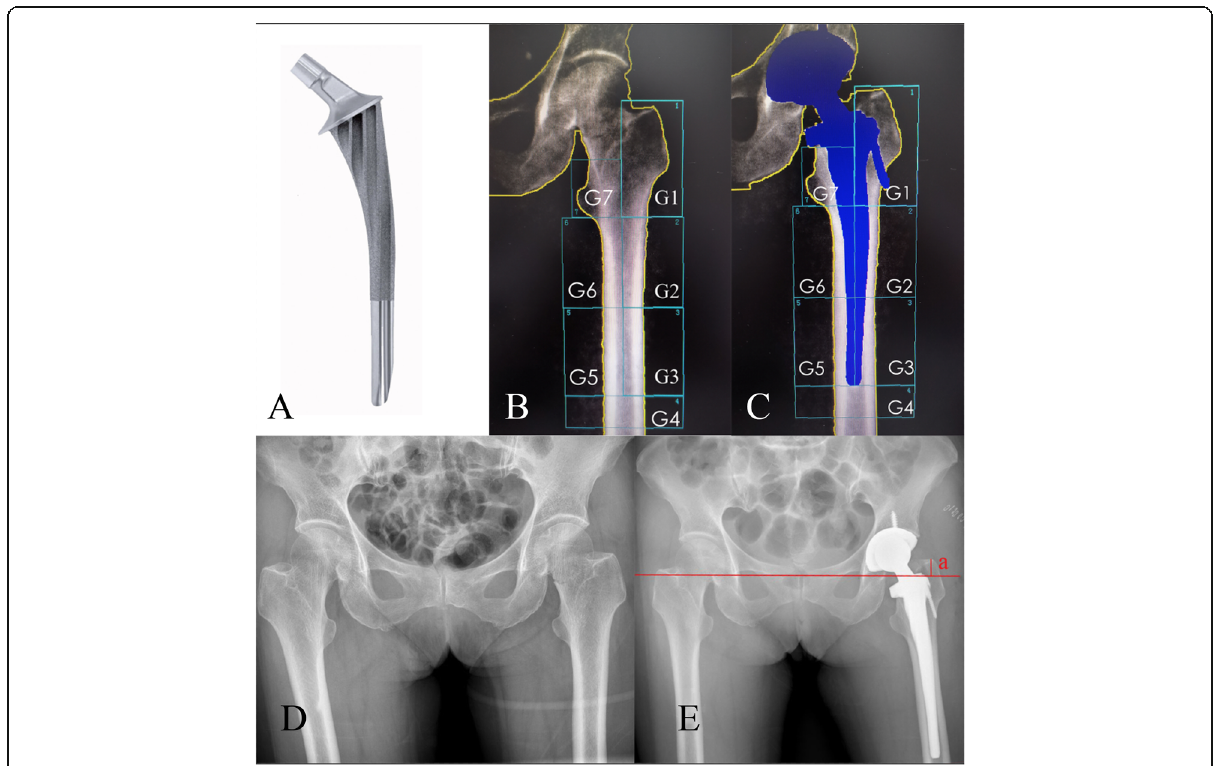
Fig. 1 Seven Gruen zones used in Dual-energy X-ray absorptiometrical analysis of preoperative ( a ) and postoperative ( b ) periprosthetic BMD. Preoperative and postoperative anteroposterior X-rays of the pelvic were shown in ( c and d ). On anteroposterior X-ray of the pelvis, the inferior displacement of the femoral stem was evaluated by measuring the changes of the distance between the tip of greater trochanter and interteardrop line (Line a in d ) during the follow-up period